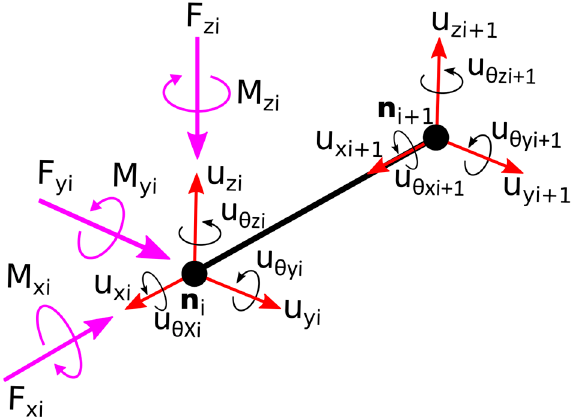
Figure 4. A single 3D beam element featuring the 12 degrees of freedom of the rail model. The forces F xi , F yi , F zi and moments M xi , M yi , M zi are the wheel forces applied to the node n i . At the next step, the forces F xi + 1 , F yi + 1 , and F zi + 1 , and the moments M xi + 1 , M yi + 1 , and M zi + 1 are applied to the node n i+ 1 , and so